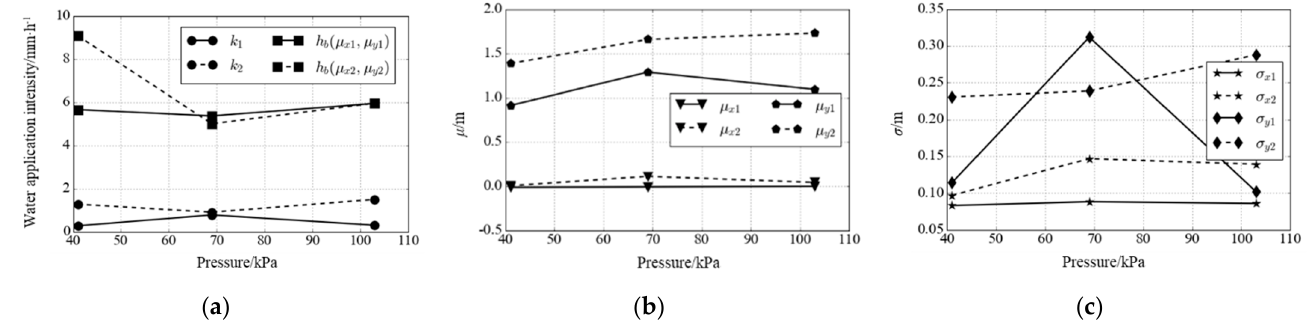
Figure 6. Fitting parameters of water application intensity on the individual orifice a 3-4 under different working pressures: ( a ) k and peak value; ( b ) µ x and µ y and ( c ) σ x and σ y . Notes: k 1 and k 2 were used to quantify the effect of the two unimodal peaks on the bimodal distribution. h b ( µ x 1 , µ y 1 ) and h b ( µ x 2 , µ y 2 ) are two peak values. µ x 1 and µ x 2 are the peak locations near and far away from an individual orifice in x direction. µ y 1 and µ y 2 are the peak locations near and far away from an individual orifice in y direction. σ x 1 and σ x 2 are the dispersion degrees of water distribution near and far away from an individual orifice in x direction; σ y 1 and σ y 2 are the dispersion degrees of water distribution near and far away from an individual orifice in y direction.